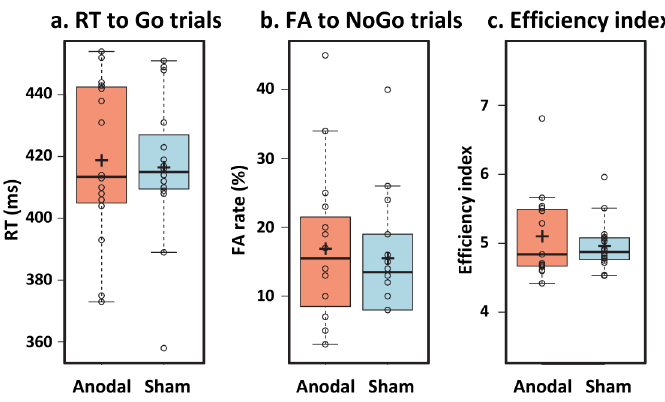
Fig 2. Behavioral results: Anodal vs. Sham stimulation. Box plots representing the RT HIT, FA rate and efficiency index in anodal and sham stimulation (a, b and c). Individual subject’s data points, the median (horizontal line), the mean (cross), and confidence intervals (Tukey whiskers) are represented.